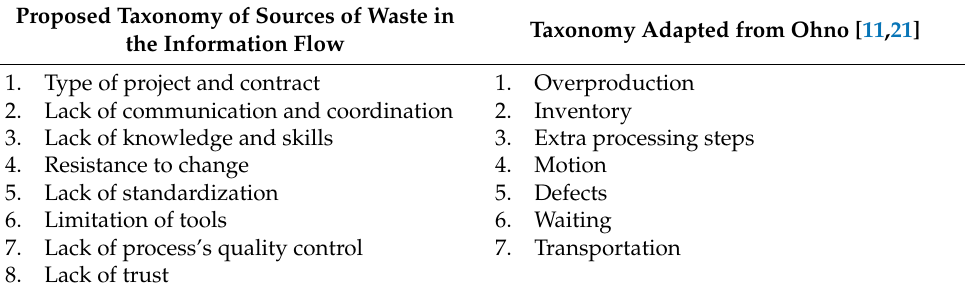
Table 3. Comparison of